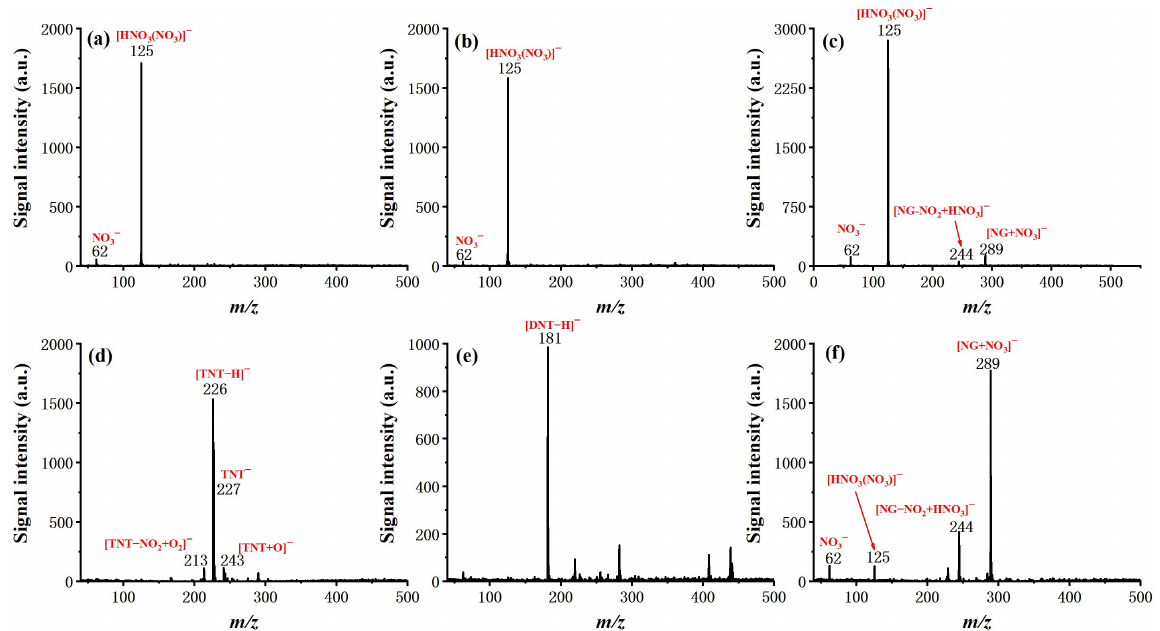
Figure 5. Mass spectra of TNT, 2,4-DNT, and NG with 100 ng, respectively, with discharge gas flow of 800 mL/min. ( a ) TNT with forward flow; ( b ) 2,4-DNT with forward flow; ( c ) NG with forward flow; ( d ) TNT with counter flow; ( e ) 2,4-DNT with counter flow; ( f ) NG with counter flow.